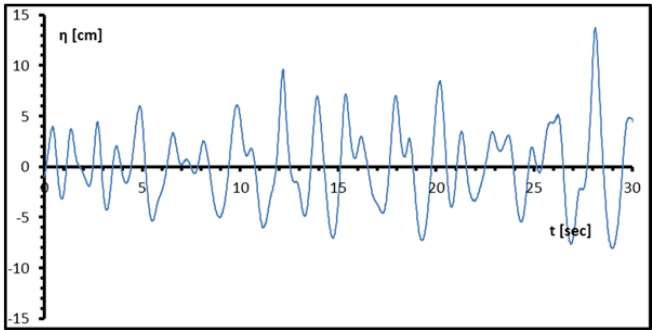
Figure 5. Water elevation η time series for Experiment #2.